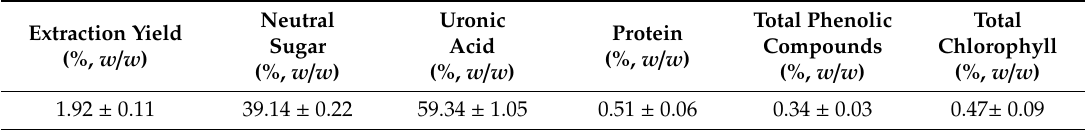
Table 1. Chemical composition of PWPs extracted from P. major L. leaves.